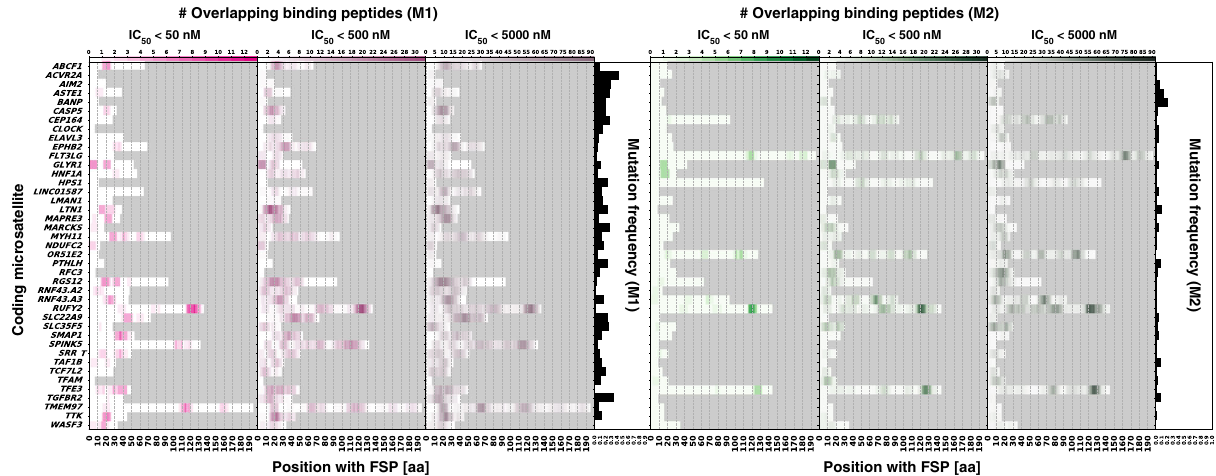
Fig. 3 MHC ligand predictions for a dataset of 82 analyzed frameshift peptides. The fi gures display the predicted epitopes for the M1 and M2 frameshift peptides derived from all 41 cMS candidates over the length of the respective peptide. All epitopes predicted for three binding af fi nity thresholds (IC 50 < 50 nM, IC 50 < 500 nM, and IC 50 < 5000nM) are shown for the M1 frameshift peptides (left, magenta) and the M2 frameshift peptides (right, green). All candidates are sorted in alphabetical order with their respective frequency of mutation according to the ReFrame results. The gray fi eld represents background and indicates C-terminal ends of the respective frameshift